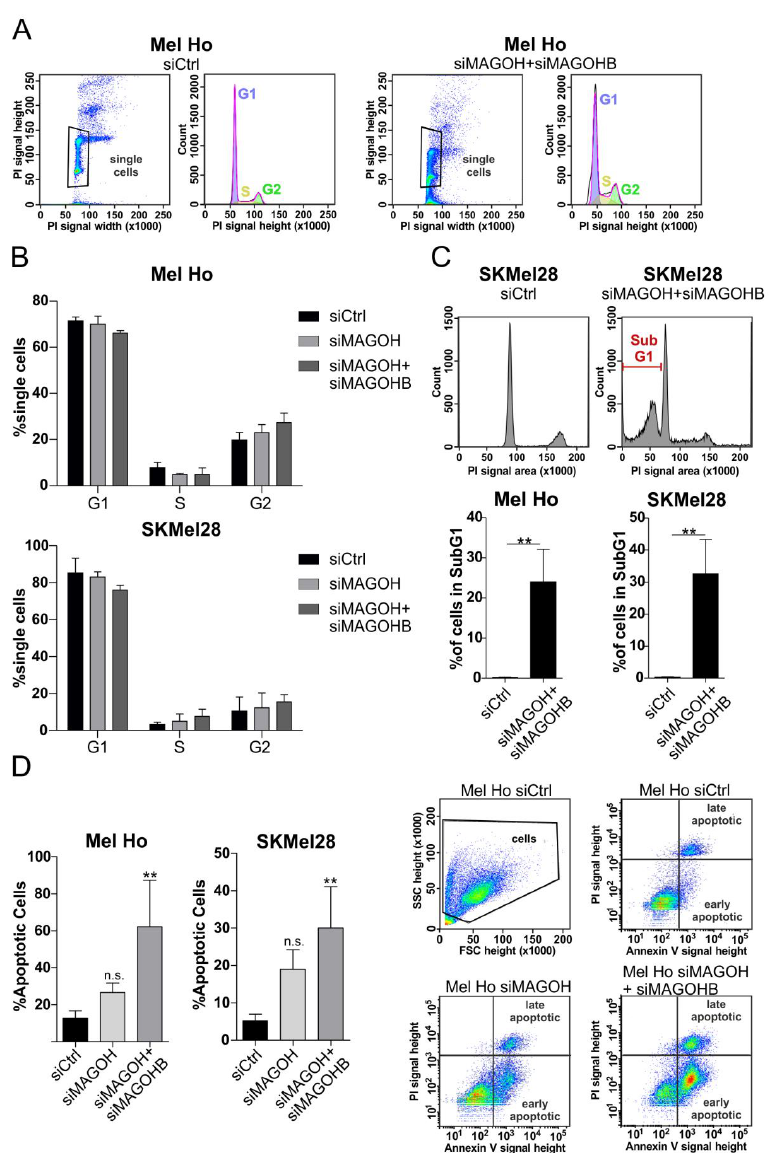
Figure 4. MAGOH and MAGOHB do not influence cell cycle progression, but a simultaneous knockdown of MAGOH and MAGOHB induces apoptosis in cutaneous melanoma. ( A ) Analysis